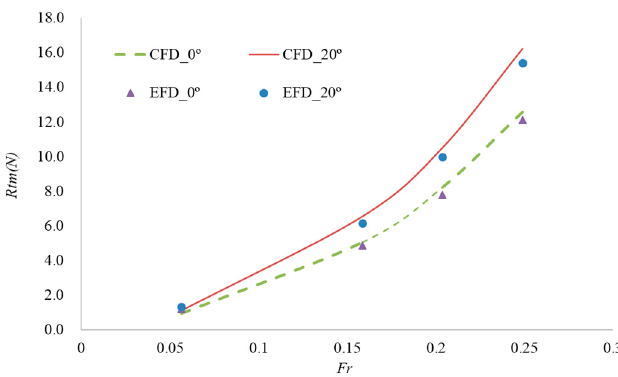
Figure 10. Resistance curves with fins.